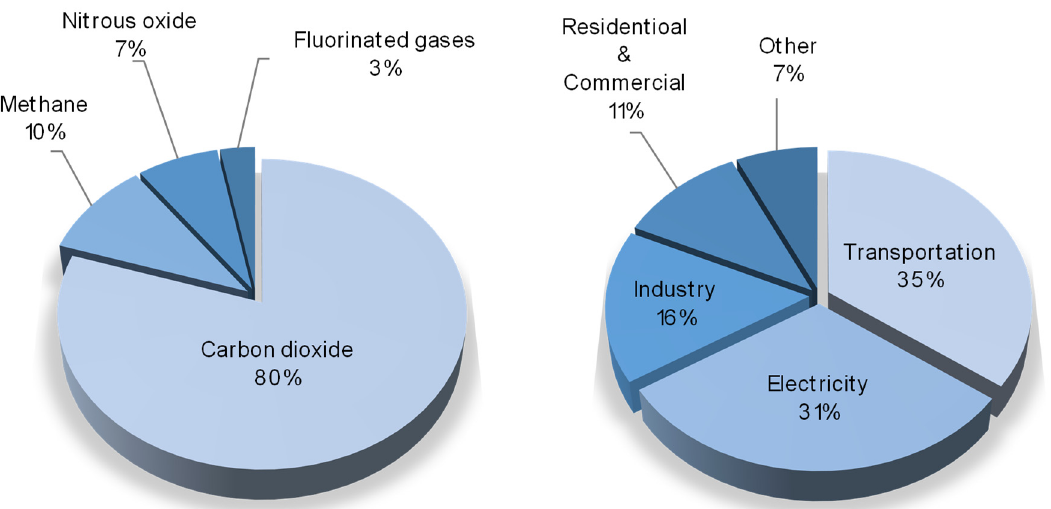
Figure 1. Some statistics on greenhouse gases emissions. Left —distribution of greenhouse gases by specific species; right —distribution of main greenhouse gases emitters.